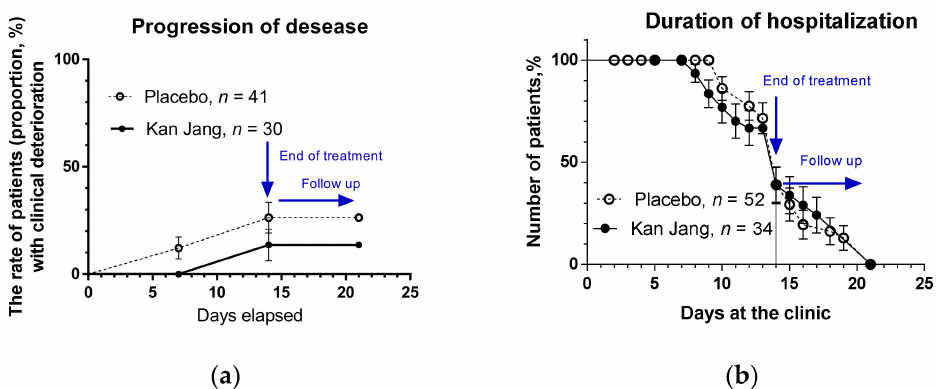
Figure 2. ( a ) The rate of patients with clinical deterioration in the treatment and control groups; hazard ratio Kan Jang/placebo = 0.4234, 95% CI of ratio from 0.132 to 1.357. ( b ) Duration of hos- pitalization in the treatment group and control group; Kaplan–Meier curves show the percent of patients hospitalized over the time from randomization (Day 1) to the end of the treatment (Day 14) and followed up for one week (Day 21) in the treatment and control groups; hazard ratio Kan Jang/placebo = 0.9398, 95% CI of ratio from 0.4978 to